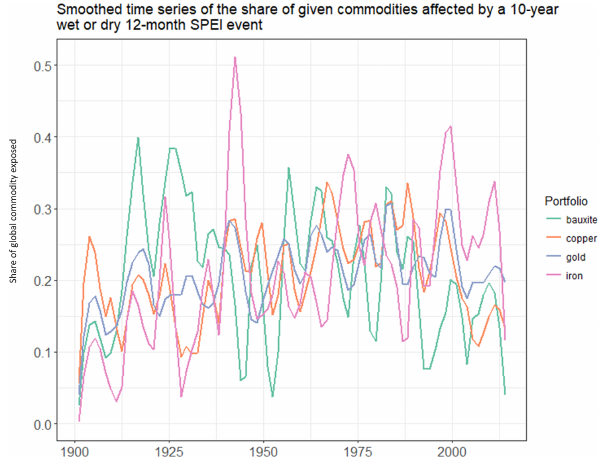
Figure 2. Time series of weighted global annual share of production exposed for different commodities with 11-year local regression- smoothed trends. Wet and dry events are considered.